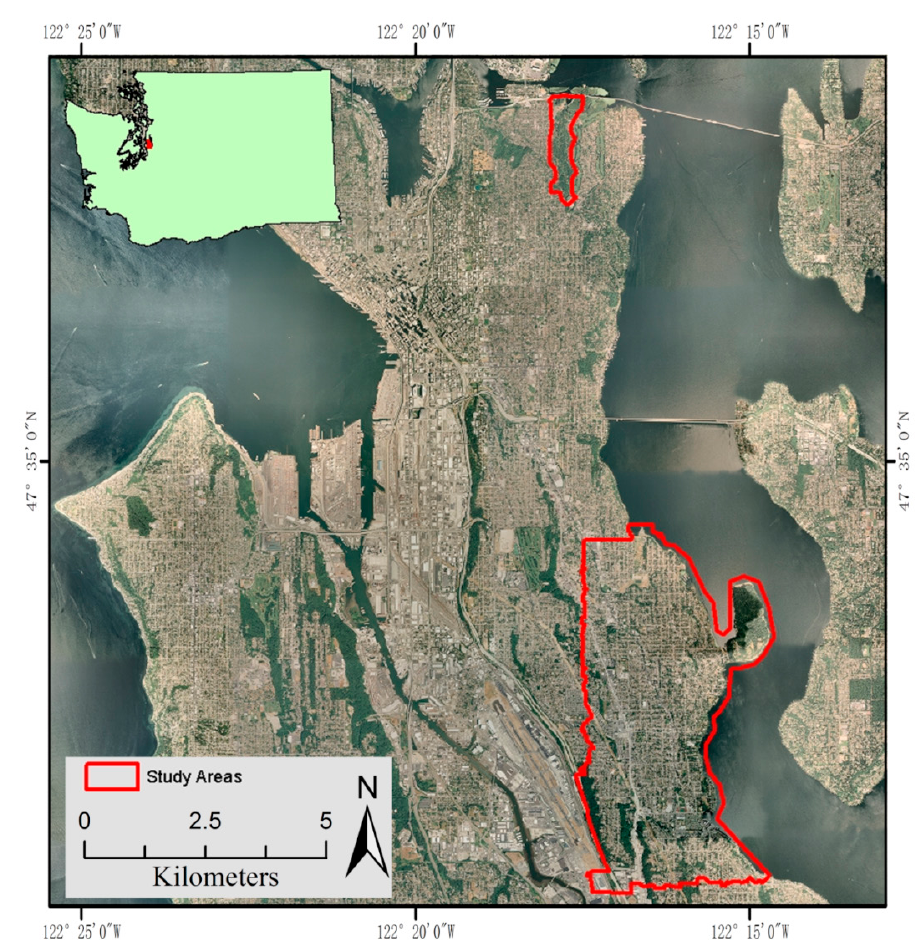
Figure 2. Location of the ZIP and WAP study areas (outlined in red).